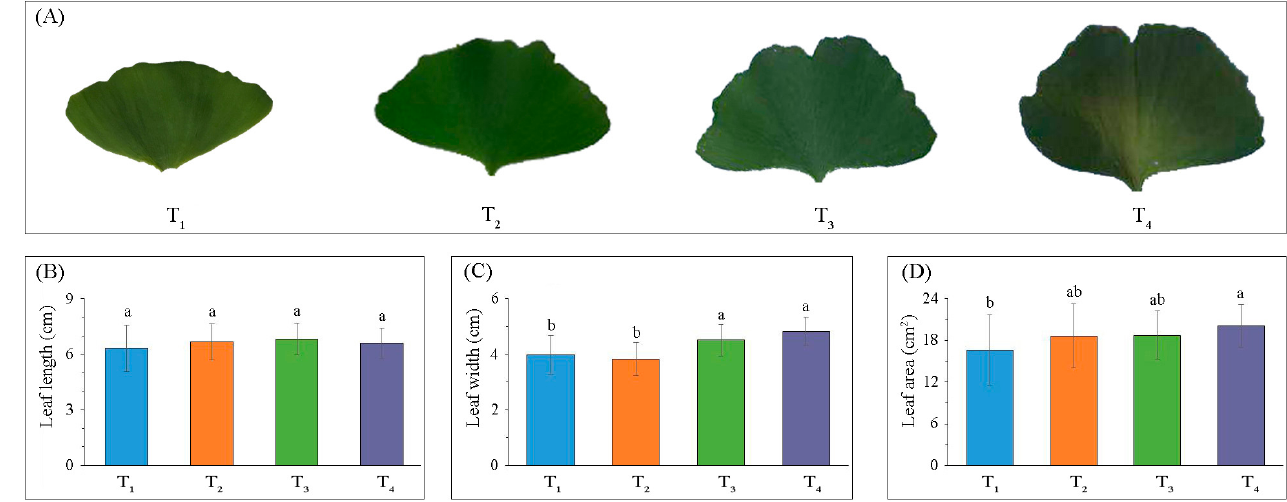
Figure 1. Variation in Ginkgo leaf morphology. Leaf morphology differences in Gingko leaf four development stages ( A ) with temporal differences in leaf length ( B ), leaf width ( C ), and leaf area ( D ) (error bars indicate standard deviations, and different letters represent significant differences ( p < 0.05)).